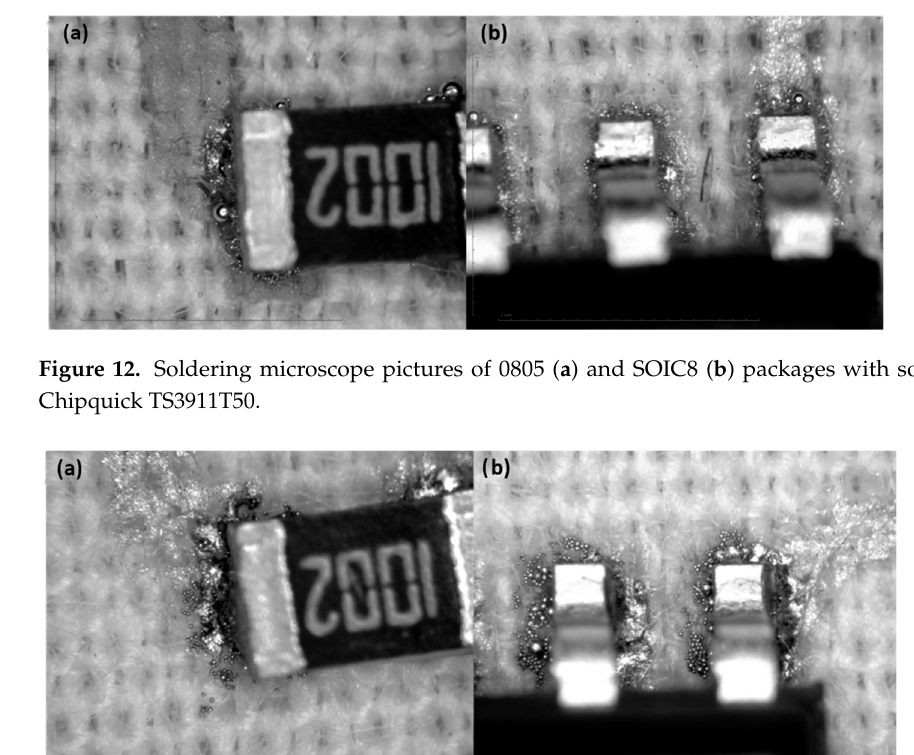
Figure 14. Soldering microscope pictures of 0805 ( a ) and SOIC8 ( b ) packages with solder paste In ‐ dium Indalloy #1E. Figure 15. Soldering microscope pictures of 0805 ( a ) and SOIC8 ( b ) packages with solder paste SRA SSLTNC.